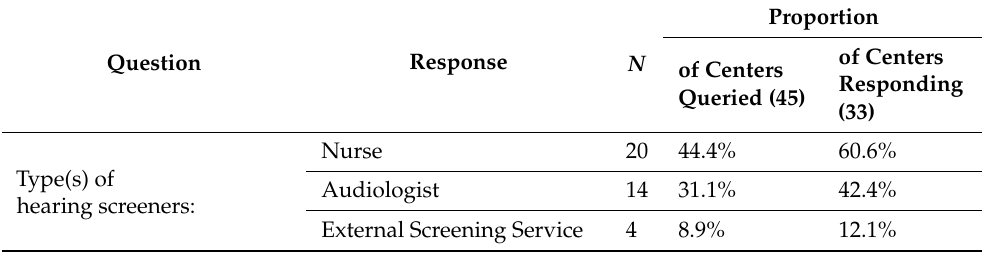
Table 3. Responses regarding newborn hearing screening practices and